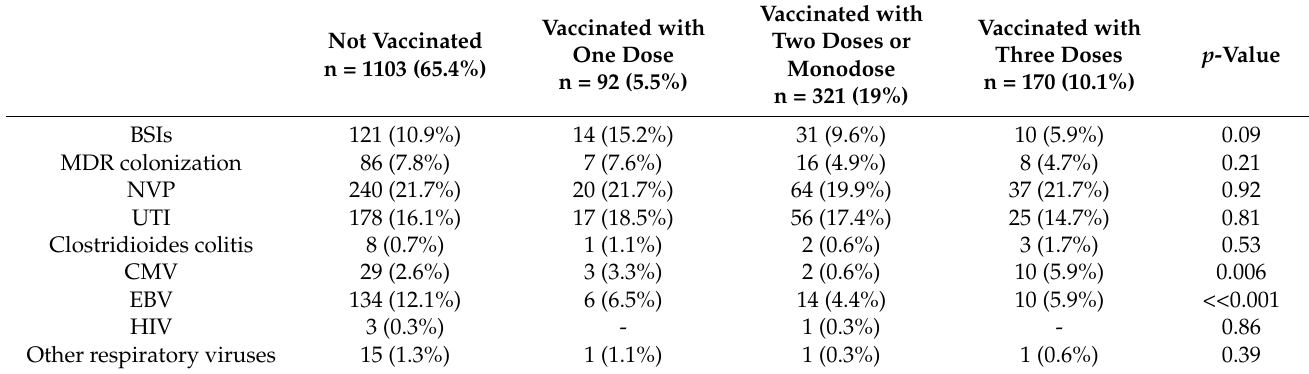
Table 3. Data about coinfections by vaccination